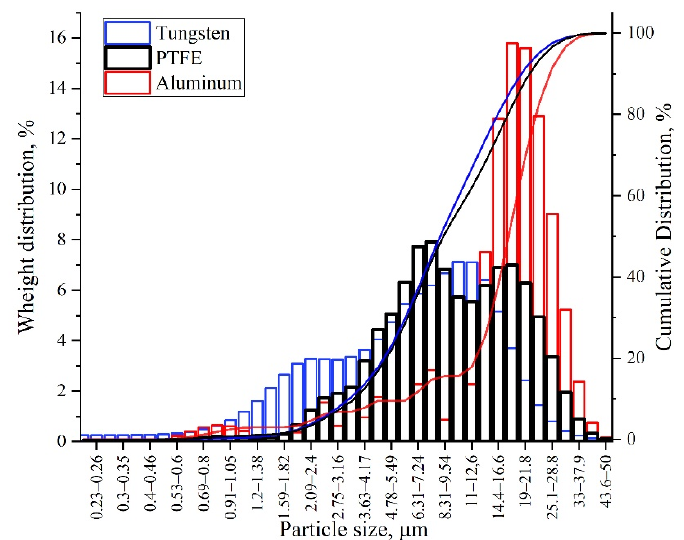
Figure 1. Particle size distribution of the initial powders. Table 1. Compositions of the specimens.